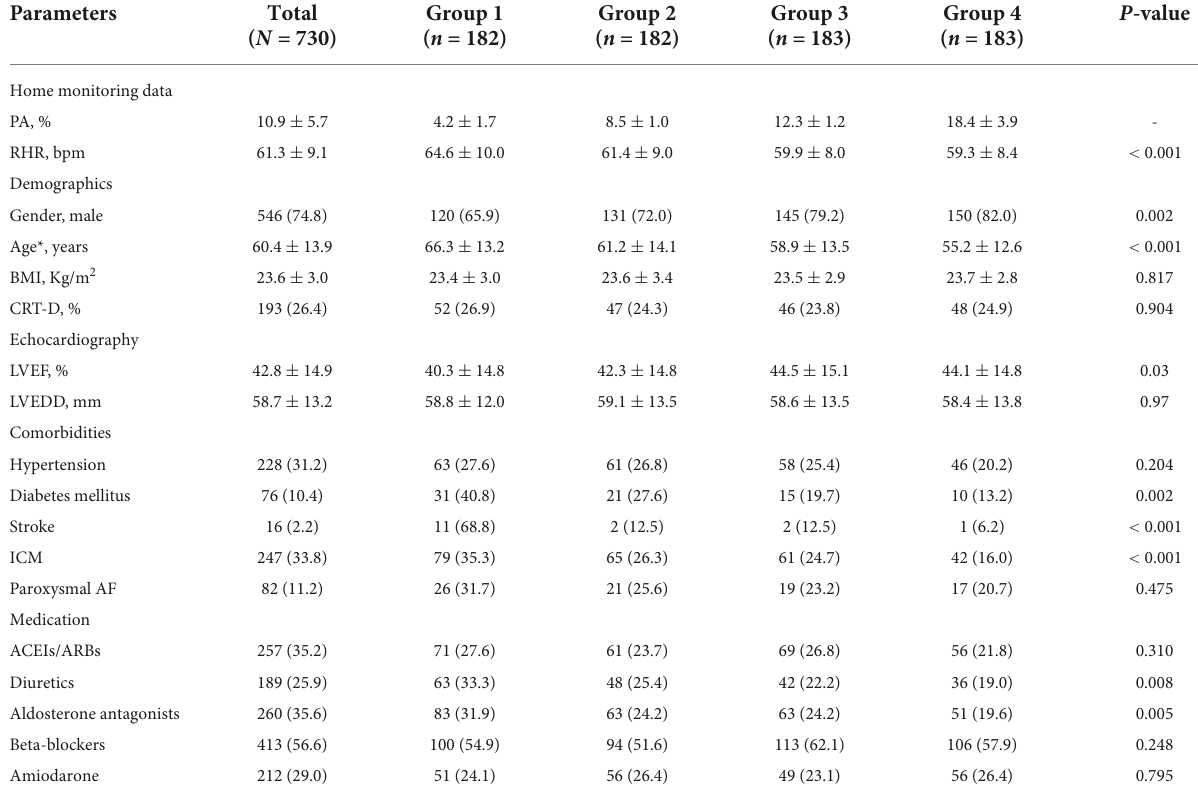
TABLE 1 Baseline